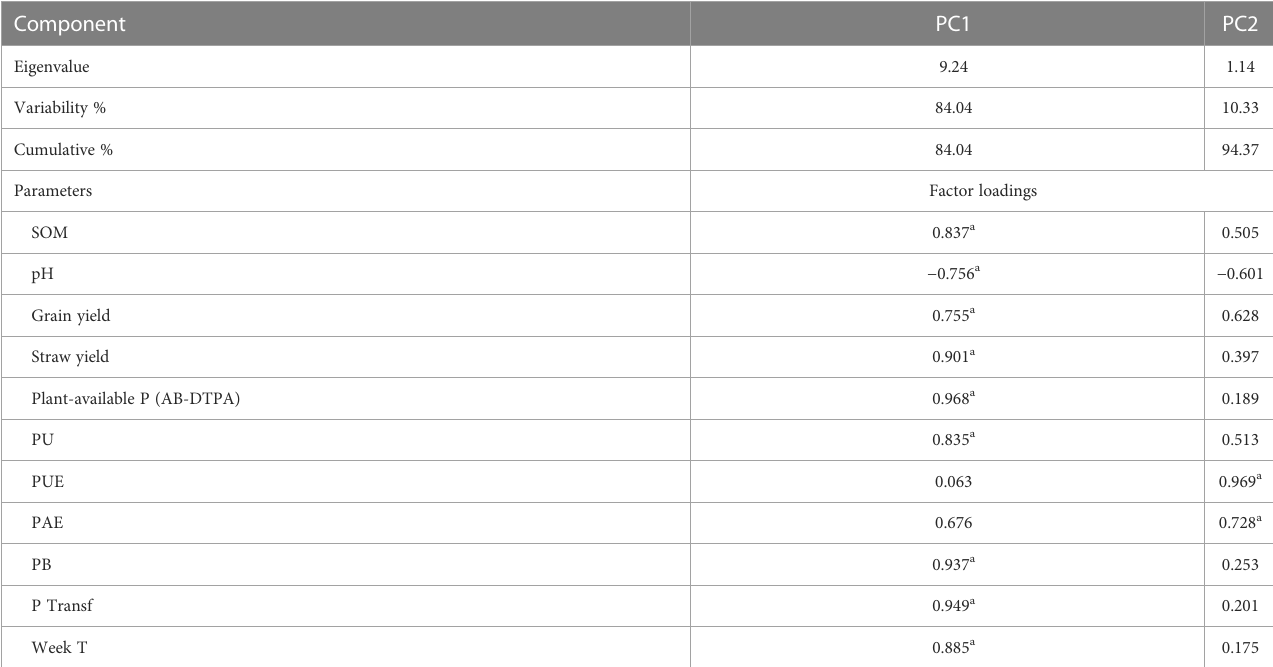
TABLE 6 Field study: Principal component analysis (PCA) of the selected trials showing the amount of variance explained by individual principal components (PC) with PCA values. Component Eigenvalue Variability % Cumulative % Parameters SOM